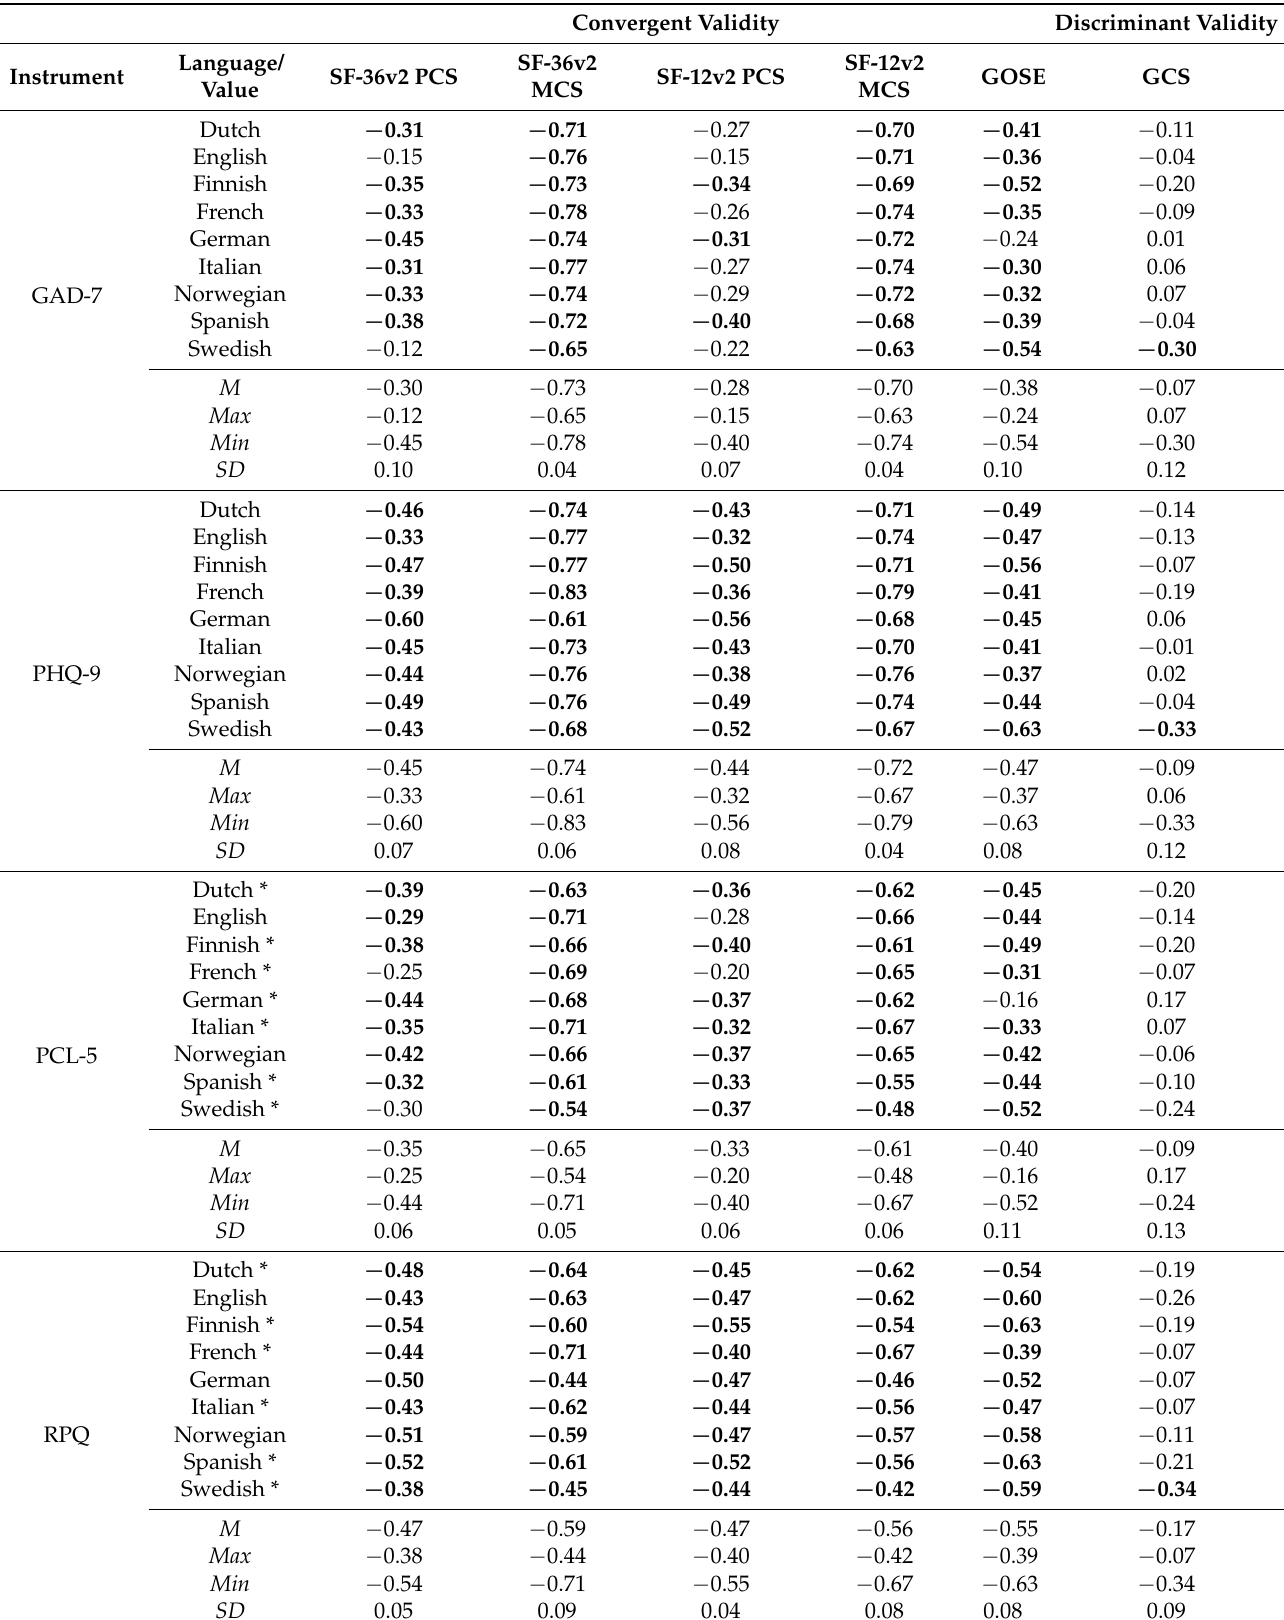
Table 9. Convergent and discriminant validity of the GAD-7, PHQ-9, PCL-5, RPQ, QOLIBRI, and QOLIBRI-OS with the SF-36v2, the SF-12v2, the GOSE, and the